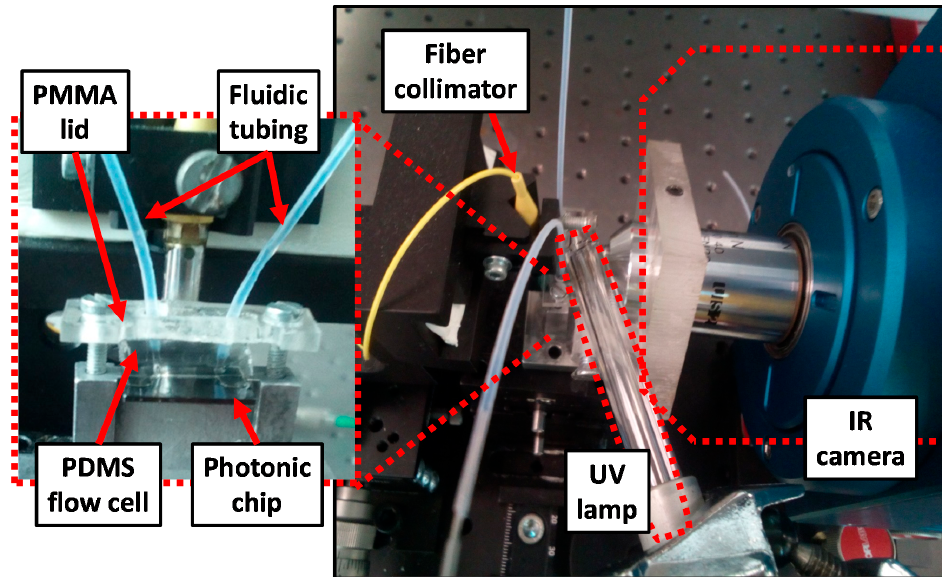
Figure 5. Experimental setup employed for the interrogation of the photonic chip containing the PBG sensing structures. The zoom image depicts the assembled photonic + fluidic chip. PMMA: Polymethyl methacrylate, PDMS: Polydimethylsiloxane, IR: Infrared.